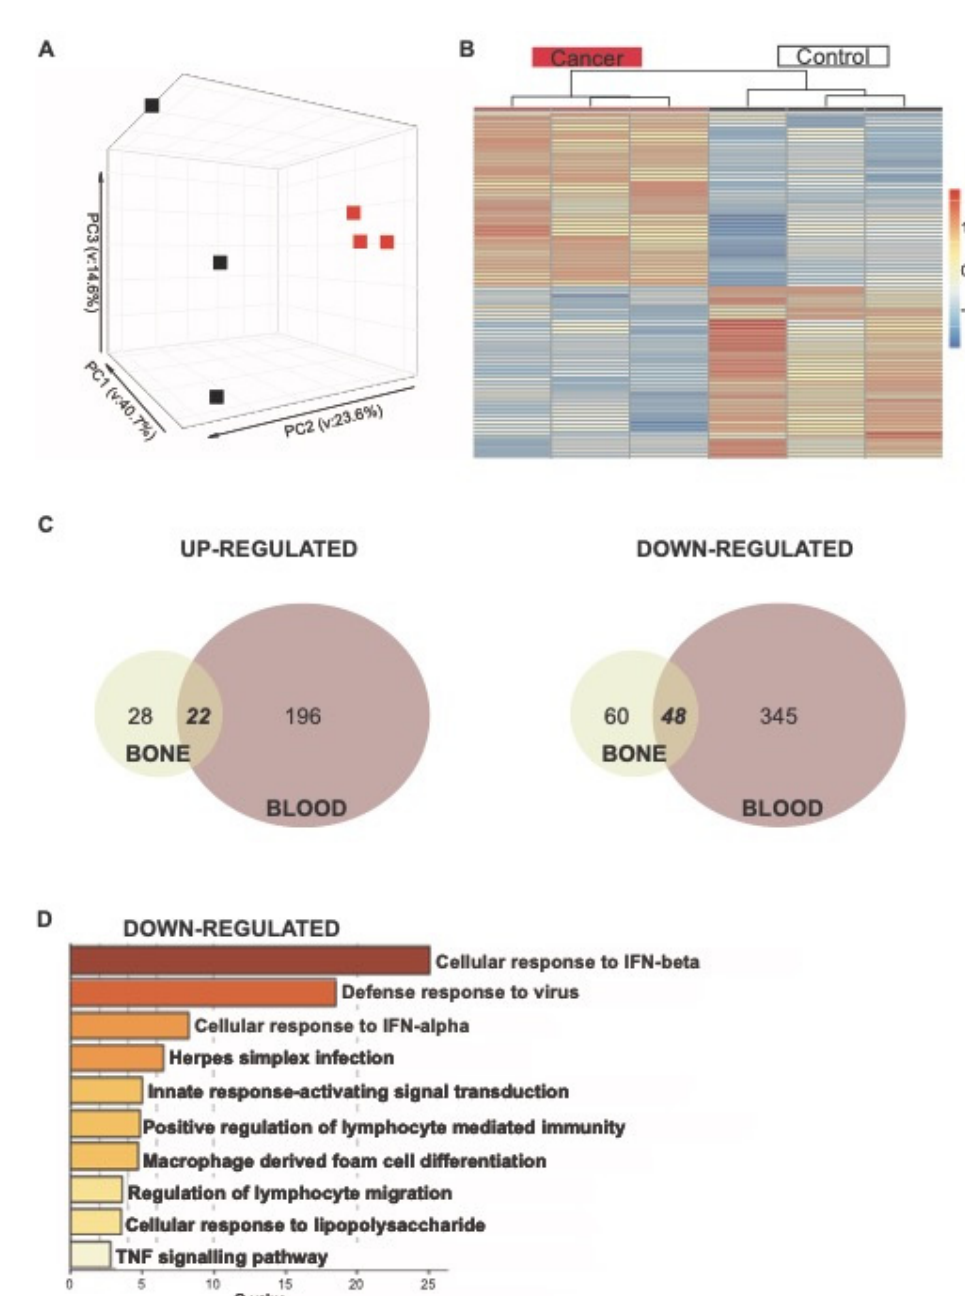
Figure 6. Analysis of RNA-seq of Ly6Chigh bone and blood monocytes. ( A ) PCA of Ly6c high bone monocytes. ( B ) Gene expression heatmap of Ly6C high bone monocytes DEGs comparing control and cancer samples with a q.value < 0.05. Samples are arranged horizontally, and sample characteristics are provided in horizontal bars for each column denoting cancer in red and control in black, with the date samples sorted in purple and blue. Genes are arranged vertically; within the heatmap, red indicates up-regulation and blue indicates down-regulation based on the tpm z-score (range ( − 2, 2)). Samples are clustered using complete linkage and Pearson correlation. ( C ) Venn diagram for DEGs in BM (cream) and blood (red) that are up-regulated and down-regulated in cancer. ( D ) Pathways for 47 shared down-regulated genes. Log q.values are plotted, and each bar colored according to the log q.value on a scale of 0 to 30, represented with graduating intensity from cream to dark brown. Gene Ontology or KEGG terms are